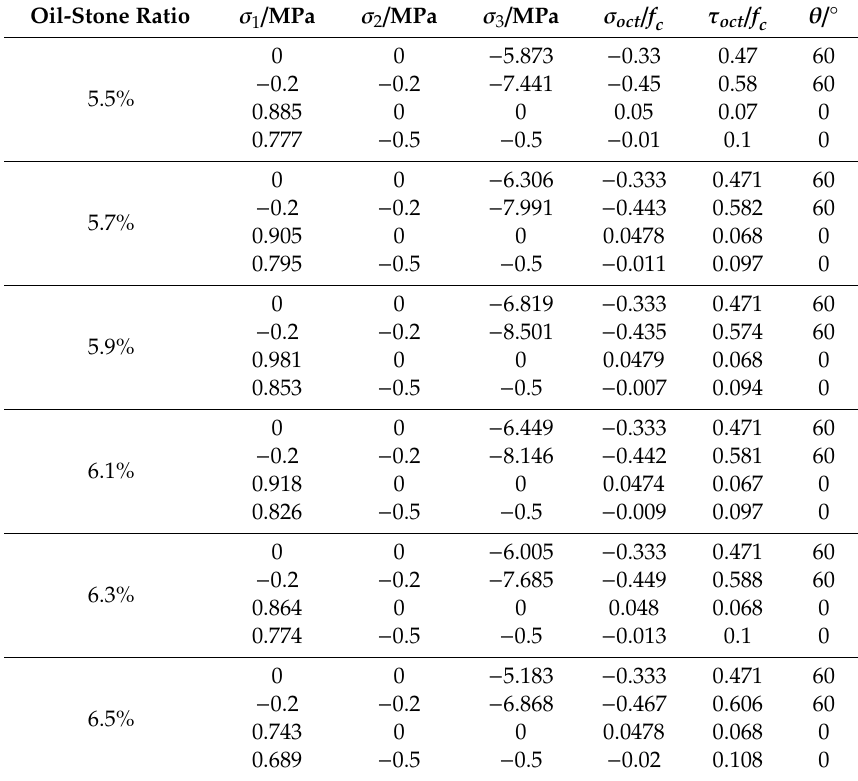
Table 6. Test results of asphalt mixture under di ff erent oil-stone ratio.